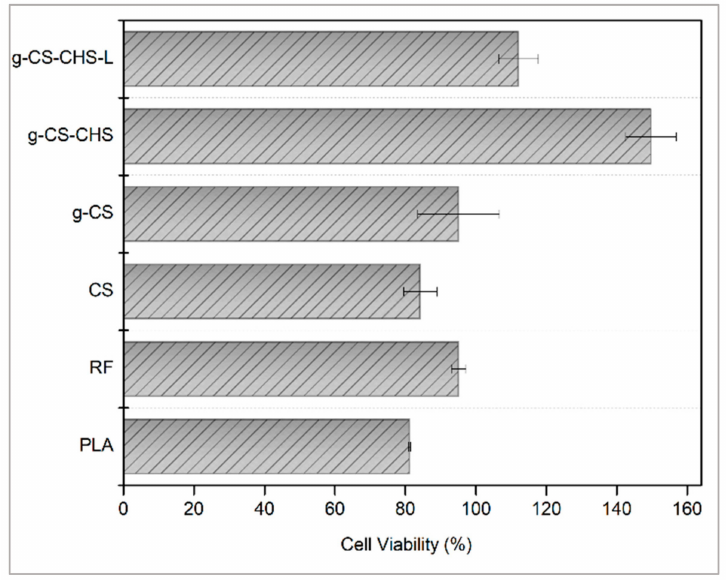
Figure 6. Cytotoxicity of untreated, plasma treated, CS and/or ChS coated, lomefloxacin loaded PLA